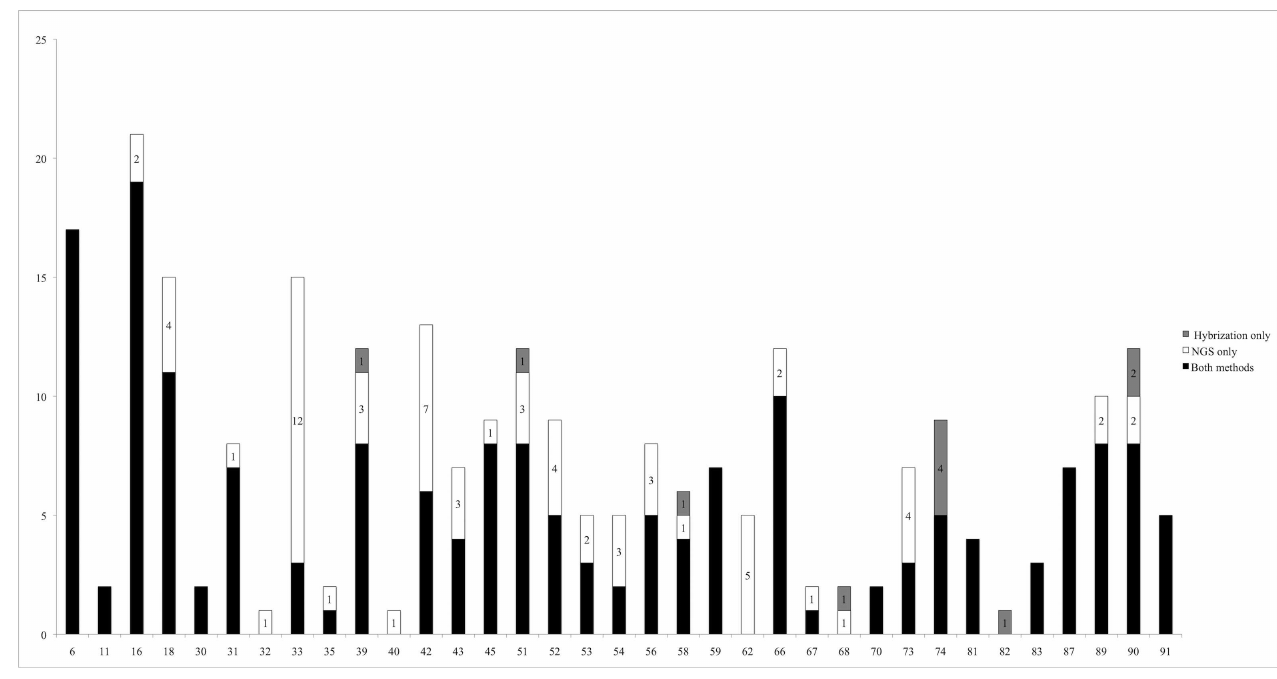
Fig 1. HPV type-specific detections by hybridization and NGS. The numberof HPV detectionsin 85 urine samplesis given on the Y-axis and the individual HPV types are given on the X-axis. Black bars show detectionsmade by both methods; grey bar sections show detectionsmade by hybridization only and white bar sections show detectionsmade by NGS only.